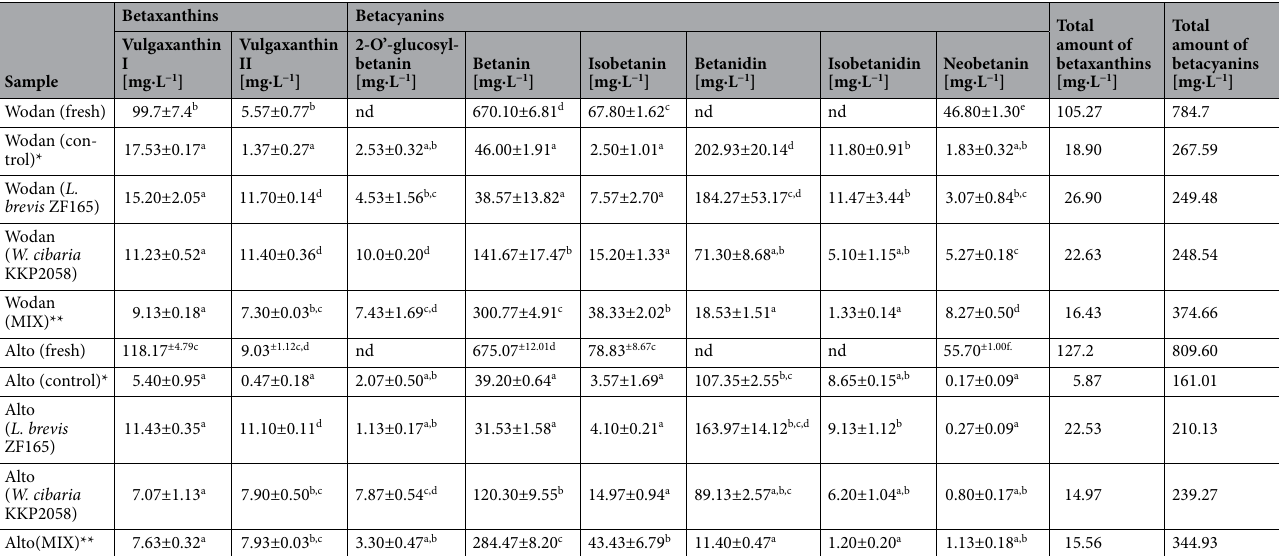
Table 1. Total content and quantitative composition of betalains found in fresh and fermented red beet juices of Wodan and Alto variety. *Control: spontaneous fermentation. **MIX: L. brevis ZF165; W. cibaria